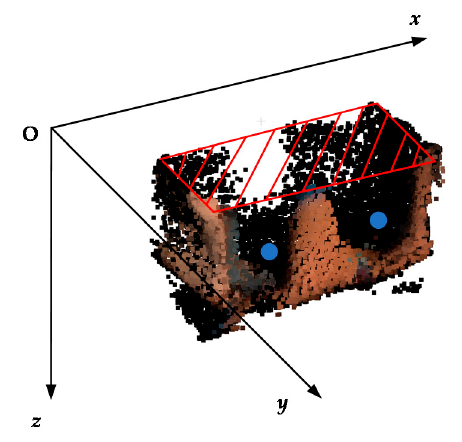
Figure 8. The virtual camera coordinate system.